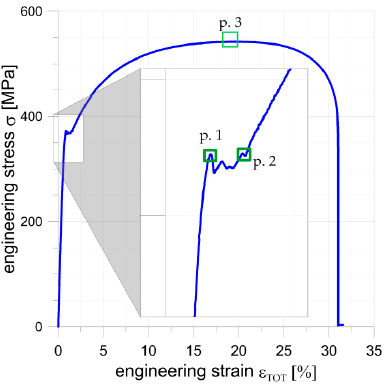
Figure 5. Photograph of sample 5 with composite reinforcement overlays at the center and covered by speckle pattern.